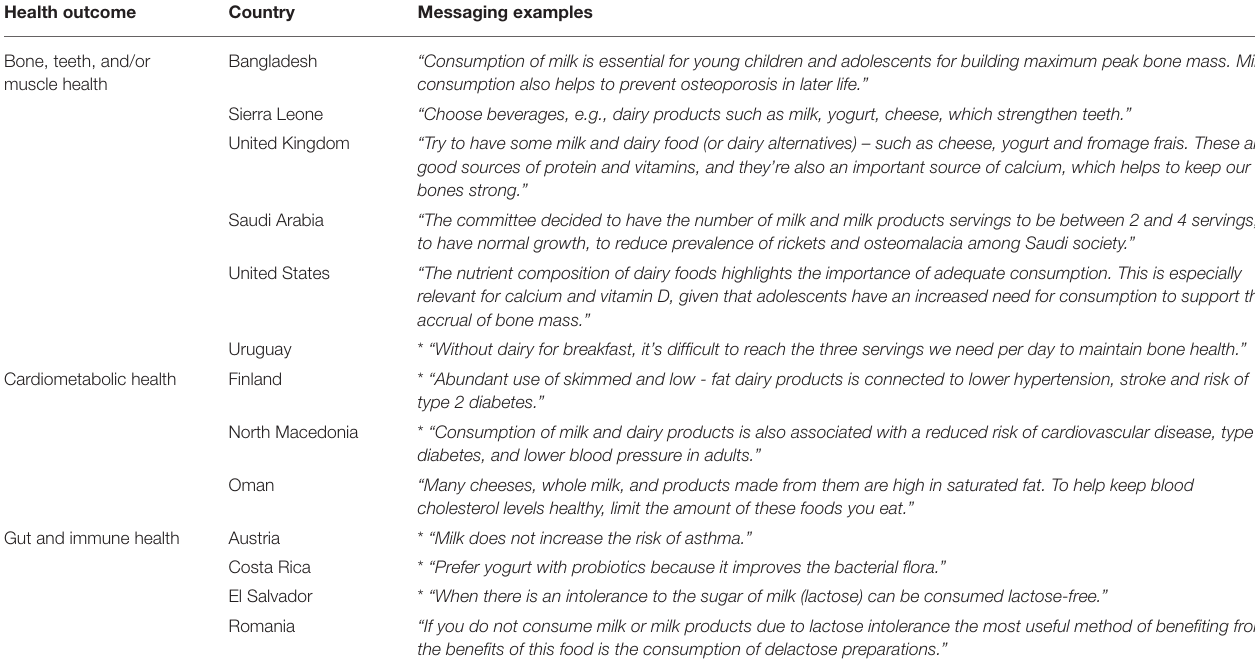
TABLE 3 | Examples of dairy and health-based messaging in FBDGs. Health outcome Country Messaging examples Bone, teeth, and/or muscle